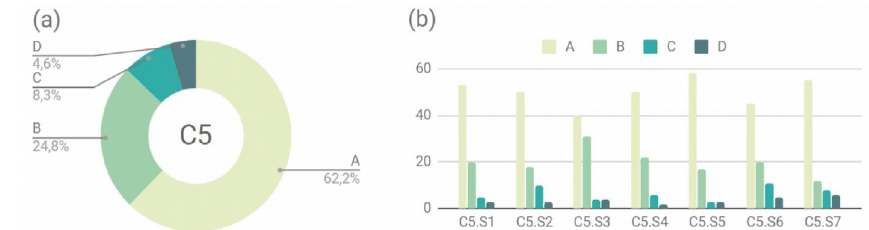
Figure 9. Student assessment of category C5. Facilitator’s Role (a) as a whole and (b) for each question. Table 3 shows the coding of the